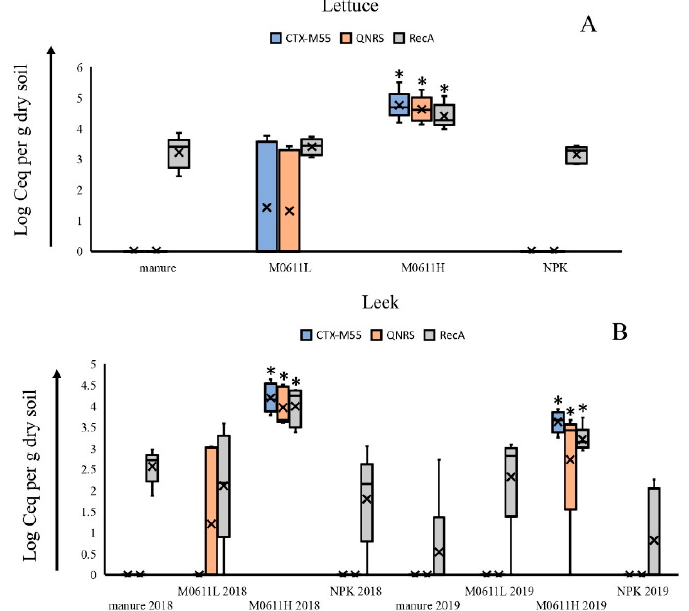
Figure 4. Molecular quantification of bla CTX-M-55, qnr S1 and rec A loci located on the strain 0611 genome and expressed in Ceq values in lettuce ( A ) and leek ( B ) rhizosphere soils under four treatment regimens, as determined by TaqMan. Average values marked with * indicate significant difference ( p ≤ 0.05) from values of the other soil treatments determined with the same TaqMan system.